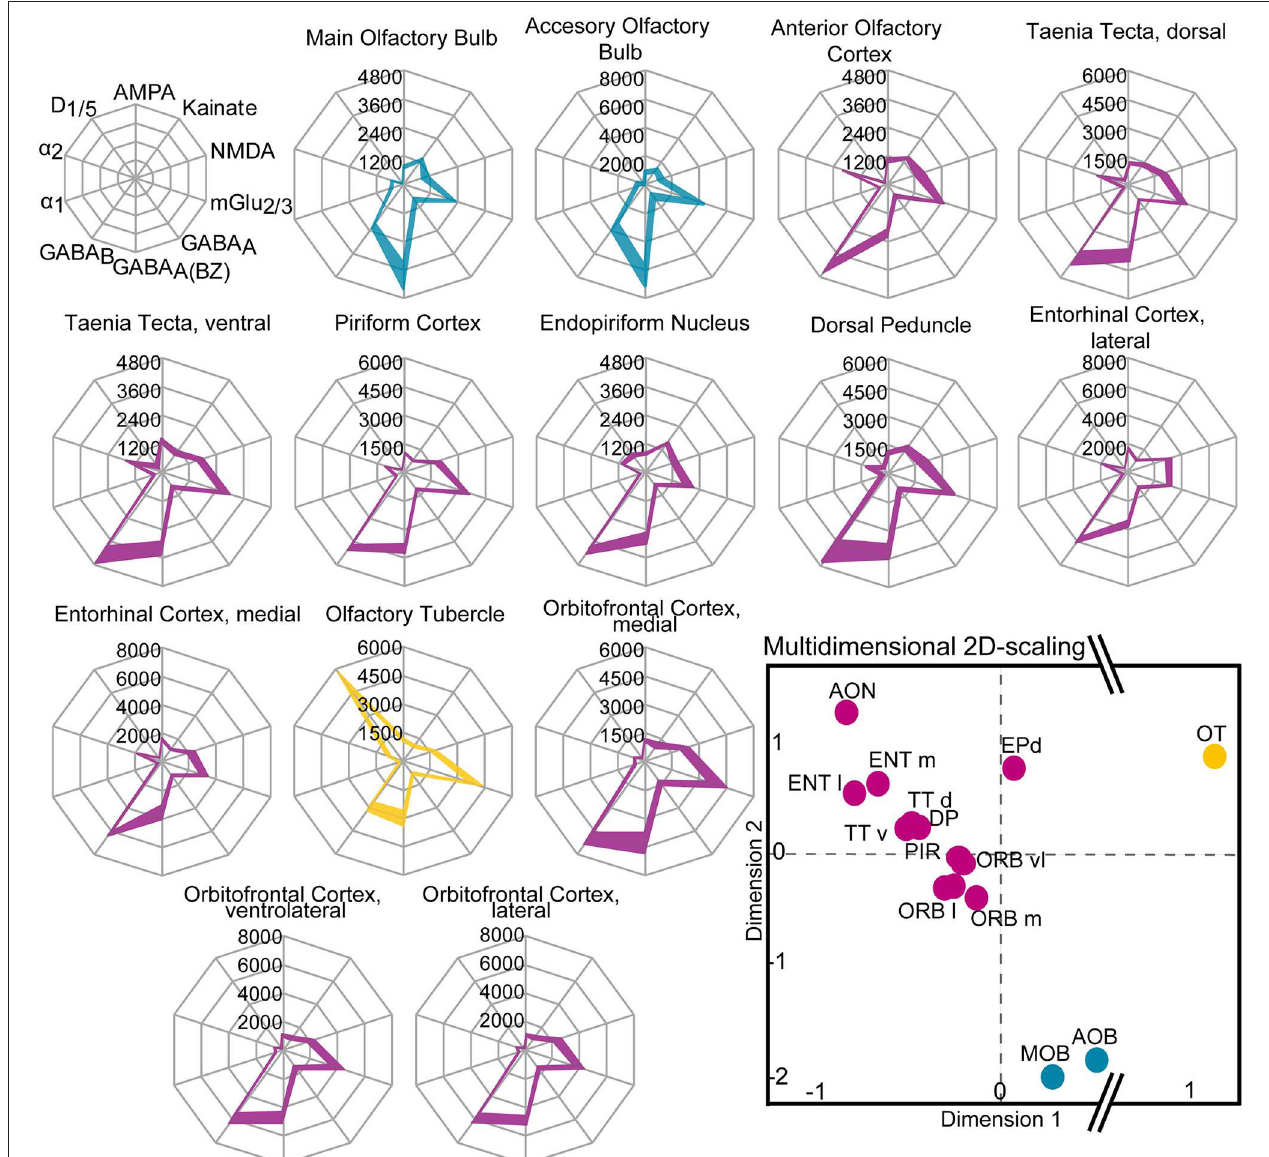
FIGURE 11 | Receptor fingerprints of the 14 investigated olfactory areas. Mean densities (in fmol/mg protein) are provided for each individual receptor type, connected by a colored line (colors are similar to the multidimensional 2D-scaling analysis). The positions of the receptors are shown schematically in the first row. Filled areas mark upper and lower standard errors of the mean values of the receptor densities ( ± SEM). Lower right: Receptor-driven multidimensional 2D-scaling of the olfactory system. The dots represent a receptor feature vector, based on the area-specific multi-receptor balance of all investigated receptors (averaged over ten animals/hemispheres). The closer the dots, the smaller the Euclidean distance and the higher the similarity of the receptor architecture of the investigated areas. The hierarchical cluster analysis resulted in a three-cluster solution: the olfactory relay centers (blue), the cortical olfactory areas (violet) and the olfactory tubercle (yellow). The olfactory tubercle shows the highest Euclidean distance from all other areas (interruption of the X-axis, dimension 1). For abbreviations see ( Figure 1 ).